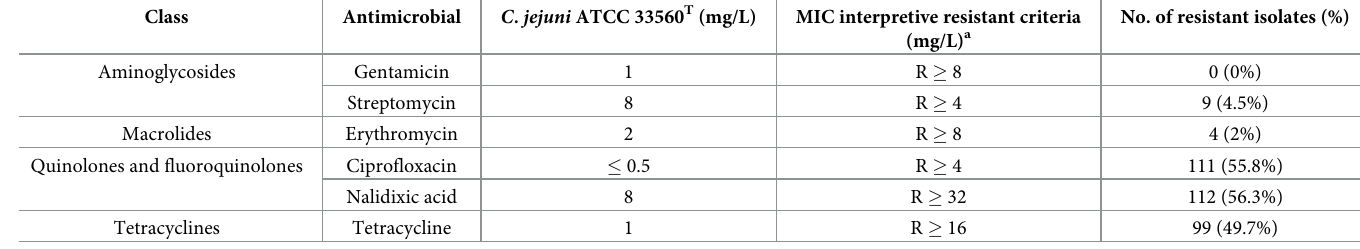
Table 1. Antimicrobial resistance rates of clinical C . jejuni .